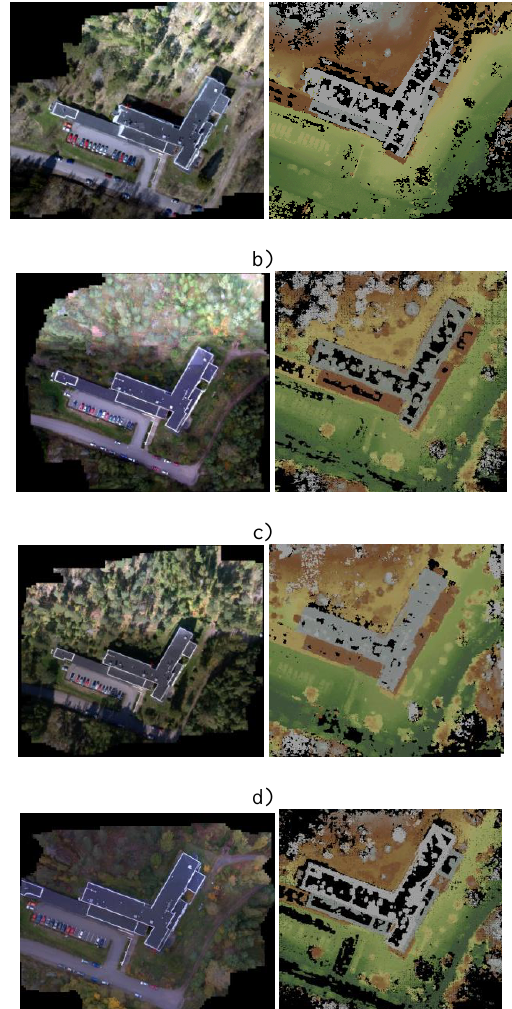
Figure 2. Multi-temporal orthophotomosaics and point clouds of the FGI main building where colour indicates height value and in black regions matching was not